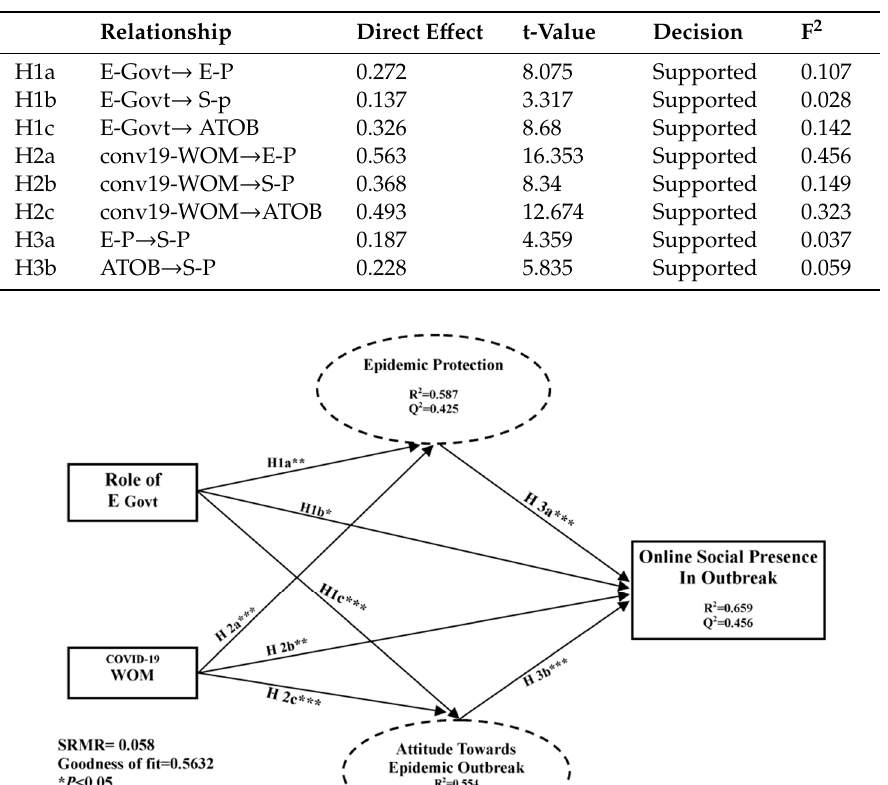
Table 5. Structured model.